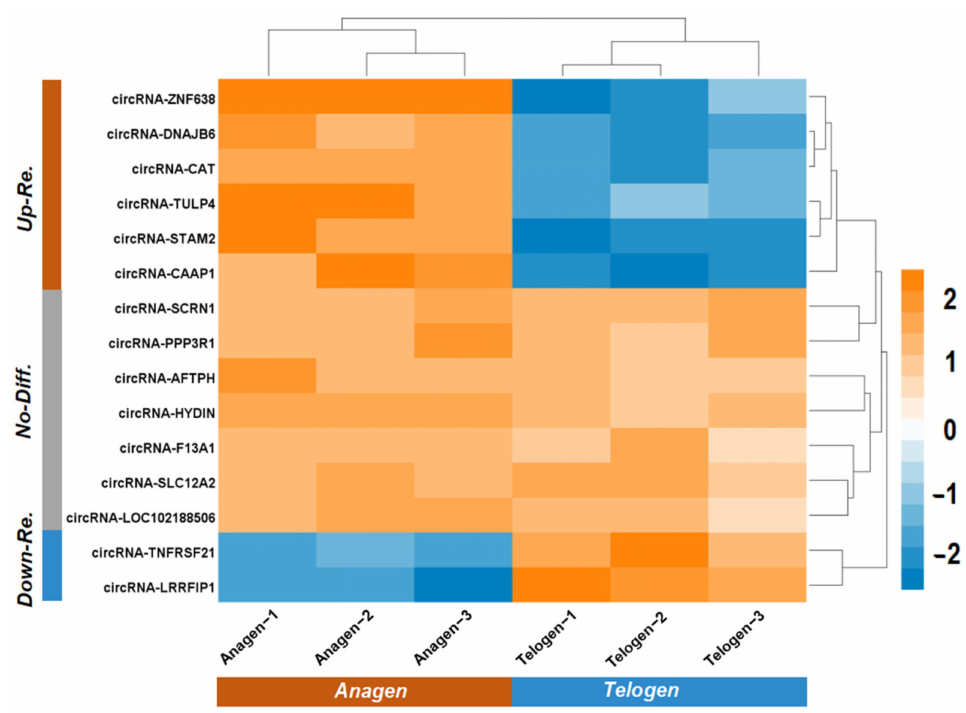
Figure 3. Expression analysis of 15 putative m 6 A-circRNAs in skin tissue of cashmere goats at both anagen and telogen stages presented as a hierarchical clustering heatmap. The “Up-Re” indicates the expression mean of putative m 6 A-circRNAs being significantly up-regulated in skin tissue at anagen of cashmere goats in comparison to telogen ( p < 0.05). The “Down-Re” indicates the expression mean of putative m 6 A-circRNAs being significantly down-regulated in skin tissue at anagen of cashmere goats in comparison to telogen ( p < 0.05). The “No-Diff” indicates no significant difference in expression mean of putative m 6 A-circRNAs in skin tissue of cashmere goats between anagen and telogen stages ( p > 0.05). The resulting p -value for each comparison is presented in Table